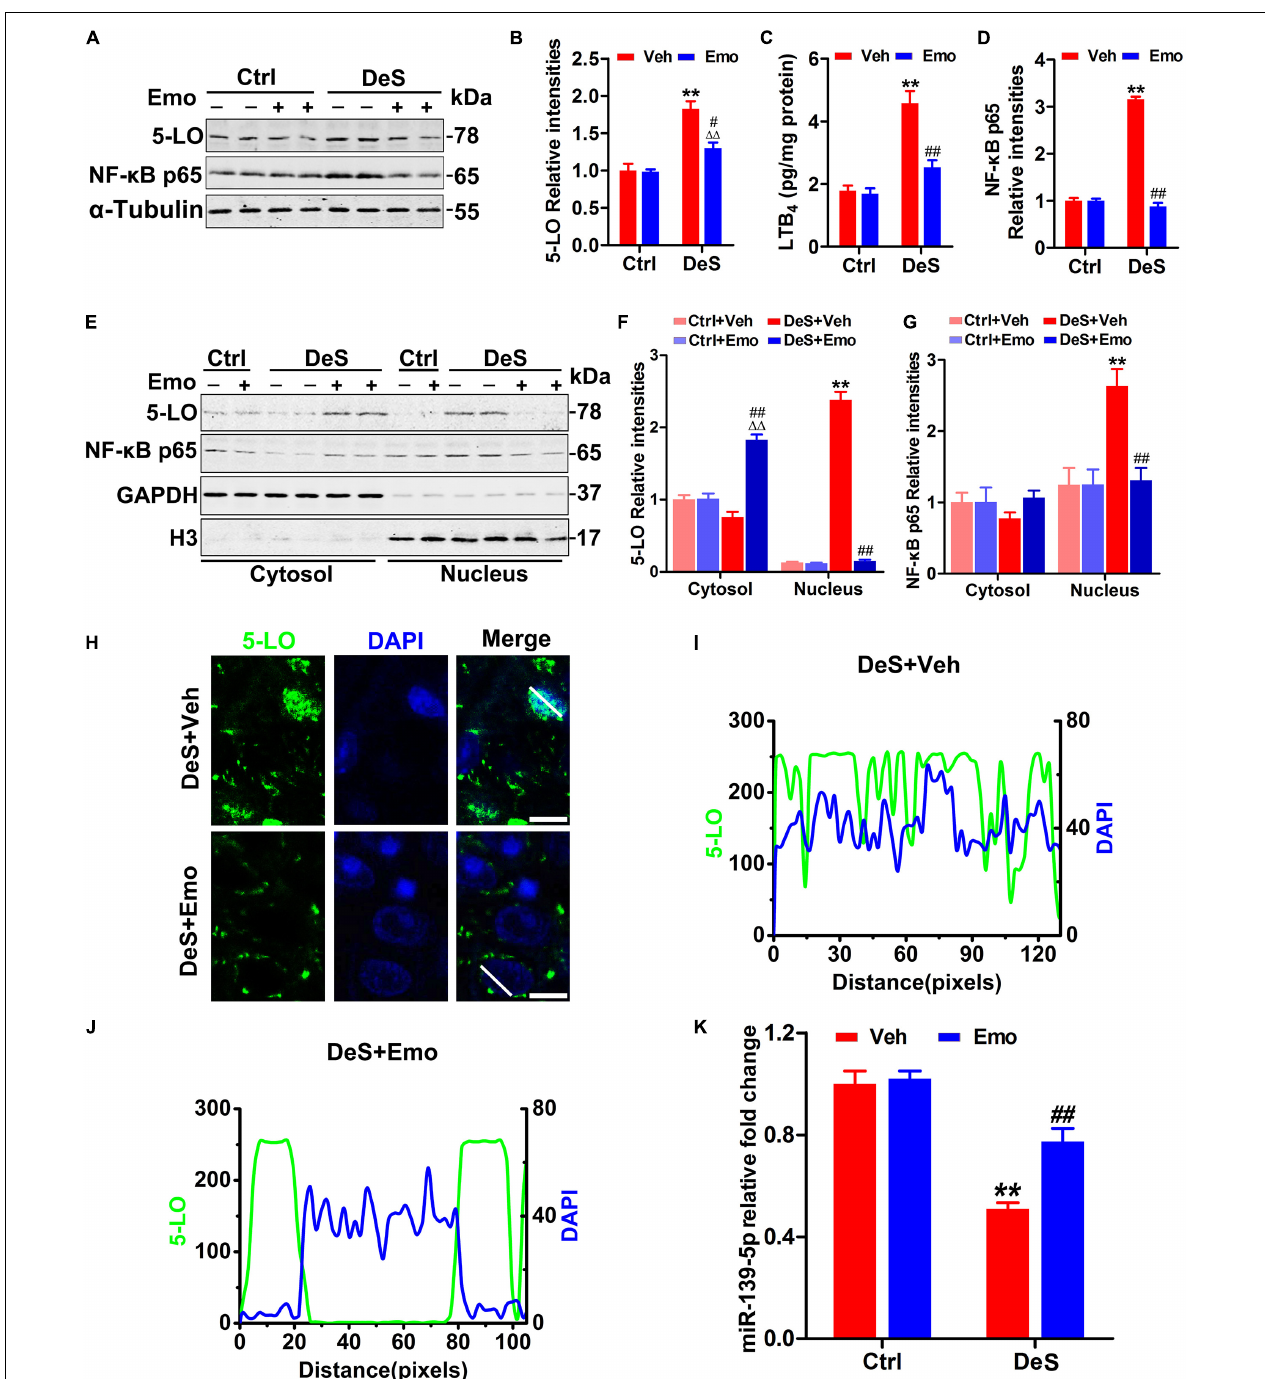
FIGURE 4 | Emodin inhibited the activation of 5-LO and nuclear factor- κ B (NF- κ B) by up-regulating miR-139-5p. Hippocampal levels of 5-LO and activated NF- κ B (NF- κ B p65) were tested by Western blotting (A) and quantitative analysis (B,D) [ F ( 3 , 20 ) = 45.668 for 5-LO, p = 0.000; F ( 3 , 20 ) = 541.762 for NF- κ B, p = 0.000] ( n = 6 brains/group). By ELISA, hippocampal levels of leukotriene B4 (LTB4) were assessed (C) [ F ( 3 , 8 ) = 26.844, p = 0.000] ( n = 3 brains/group). The levels of 5-LO and NF- κ B p65 in the nuclear and cytoplasmic fractions were detected by Western blotting (E) and quantitative analysis (F,G) ( n = 6 brains/group). The loading amount of cytosolic samples was 10 µ g and the loading amount of nuclear samples was 20 µ g. By immunofluorescence staining ( H , scale bar = 20 µ m, n = 3 brains/group) and fluorescence intensities detection ( I,J , the quantified areas were defined by the white lines), the positional relationships between 5-LO (green) and the nucleus (blue, DAPI) in CA1 neurons were shown. Hippocampal miR-139-5p was analyzed by qPCR (K) [ F ( 3 , 8 ) = 53.156, p = 0.000] ( n = 3 brains/group). Data were analyzed by one-way ANOVA with LSD post hoc test and presented as means ± S.E.M. ** p < 0.01 DeS + Veh versus Ctrl + Veh, (cid:49)(cid:49) p < 0.01 DeS + Emo versus Ctrl + Emo, # p < 0.05, ## p < 0.01 DeS + Emo versus DeS + Veh.